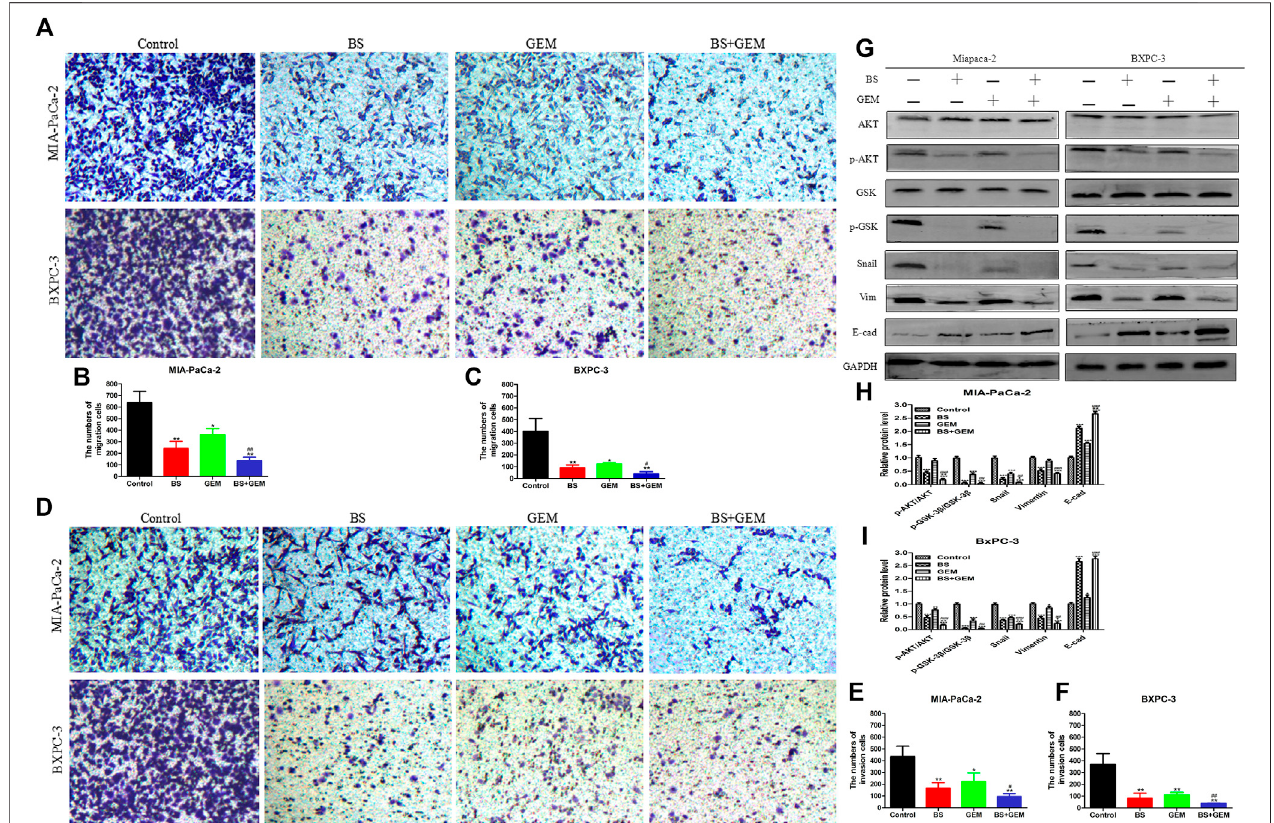
FIGURE 7 | Combination of β -sitosterol (BS) and gemcitabine (GEM) synergistically decrease migration and invasion and downregulate the expression of epithelial – mesenchymal transition (EMT) markers and AKT/GSK-3 β signaling pathways in pancreatic cancer cells. (A – C) For transwell migration assays, MIA-PaCa-2 and BXPC-3 cells weretreated withBS(250 μ M/L) and GEM (50 μ M/L) alone and incombinationfor 48 h. Thenumber ofcells werecounted under amicroscope (200 × magni fi cation).Quanti fi cationresultsareshownformigrationofMIA-PaCa-2andBXPC-3cells.Alldataaredepictedasmean ± SD( n (cid:1) 3;* p < 0.05;** p < 0.01; # p < 0.05; ## p < 0.01). (D – F) For Matrigel-coated invasion assays, MIA-PaCa-2 and BXPC-3 cells were treated with BS (250 μ M/L) and GEM (50 μ M/L) alone and in combination for 48 h. The number of cells was counted under a microscope (200 × magni fi cation). Quanti fi cation results are shown for invasion by MIA-PaCa-2 and BXPC-3 cells. All data are depicted as mean ± SD ( n (cid:1) 3; * p < 0.05; ** p < 0.01; # p < 0.05; ## p < 0.01). (G – I) MIA-PaCa-2 and BXPC-3 cells were incubated with BS (250 μ M/L) and GEM (50 μ M/L) alone and in combination for 48 h. The expression levels of Akt, p-Akt, GSK-3 β , p-GSK-3 β , Snail, vimentin, and E-cadherin were detected by western blotting. the relative protein levels of p-Akt/Akt, p-GSK-3 β /GSK-3 β , Snail, vimentin, and E-cadherin were shown in the histograms. All data are depicted as mean ± SD ( n (cid:1) 3; * p < 0.05; ** p < 0.01; *** p < 0.001; + p < 0.05; ++ p < 0.001; ## p < 0.01; ### p < 0.001).